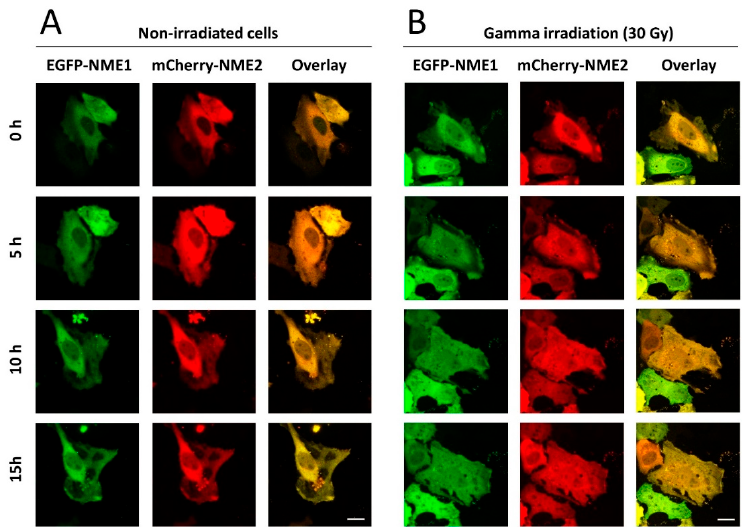
Figure 1. Time ‐ lapse live ‐ cell imaging showing subcellular localization of EGFP ‐ NME1 and mCherry ‐ NME2 in HeLa cells. The cells were observed under confocal microscope one day after transfection. ( A ) Non ‐ irradiated cells. ( B ) Cells that were exposed to gamma irradiation (Co ‐ 60) of 30 Gy approximately one hour before the time point 0 h. Scale bar, 20 μ m.